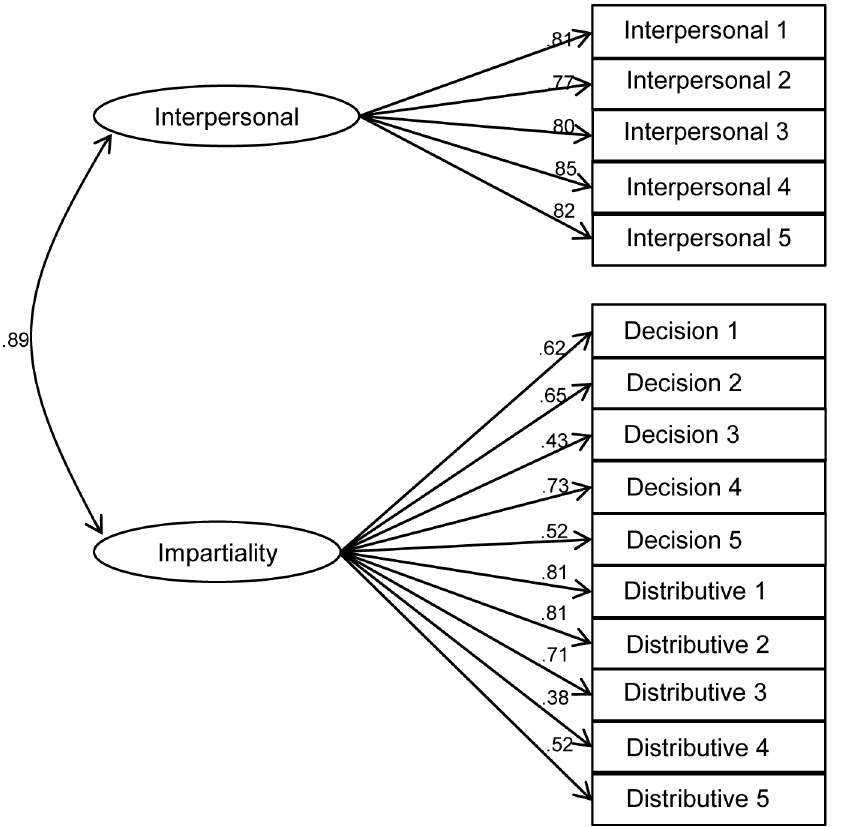
Fig 4. Alternative two-factor model of police fairness (interpersonal respectand impartiality; model C).